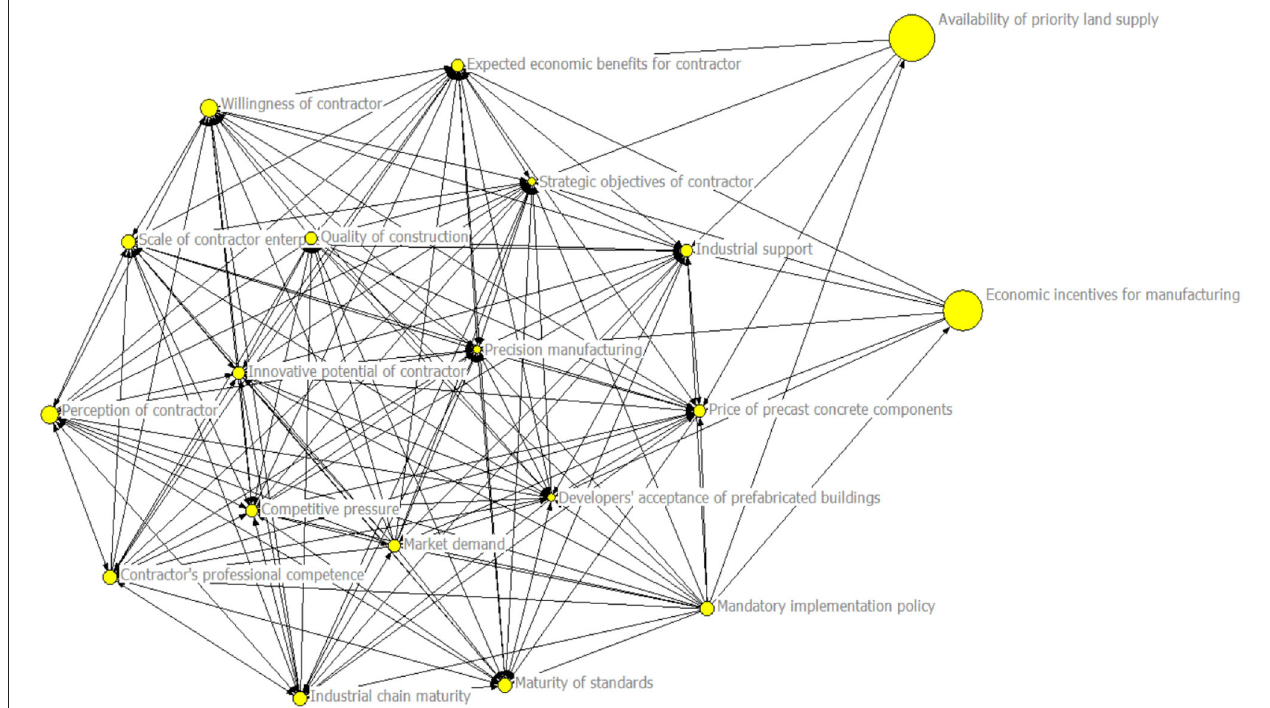
FIGURE 4 | Visual model of closeness centrality results for influencing factors.